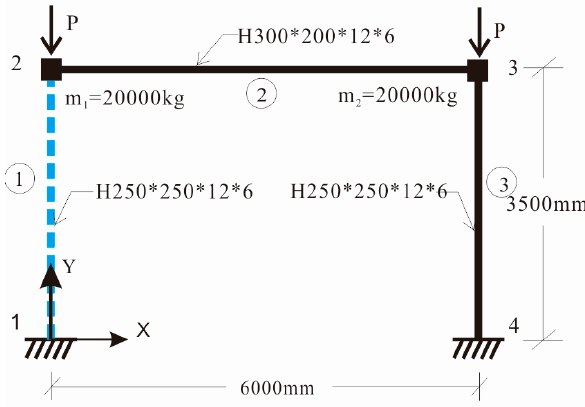
Figure 3. Schematic of one-story and one bay steel frame.